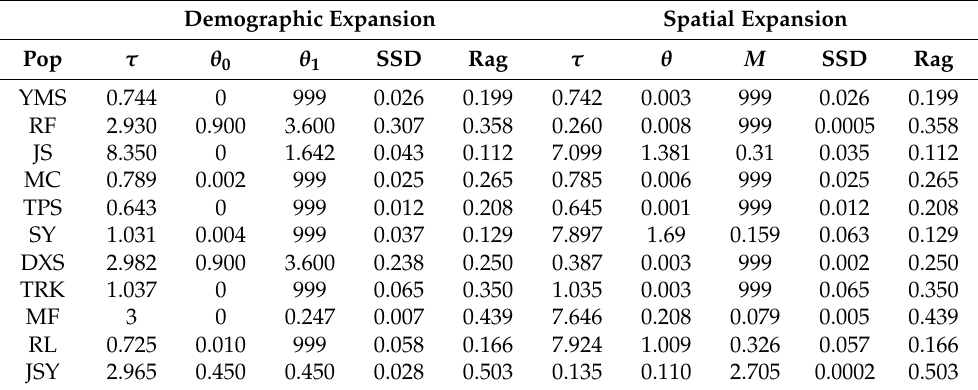
Table 3. Summary results of mismatch analysis under the demographic and spatial expansion models. Standard deviation (SD) and 95% confidence intervals (95% CI) are displayed in Table